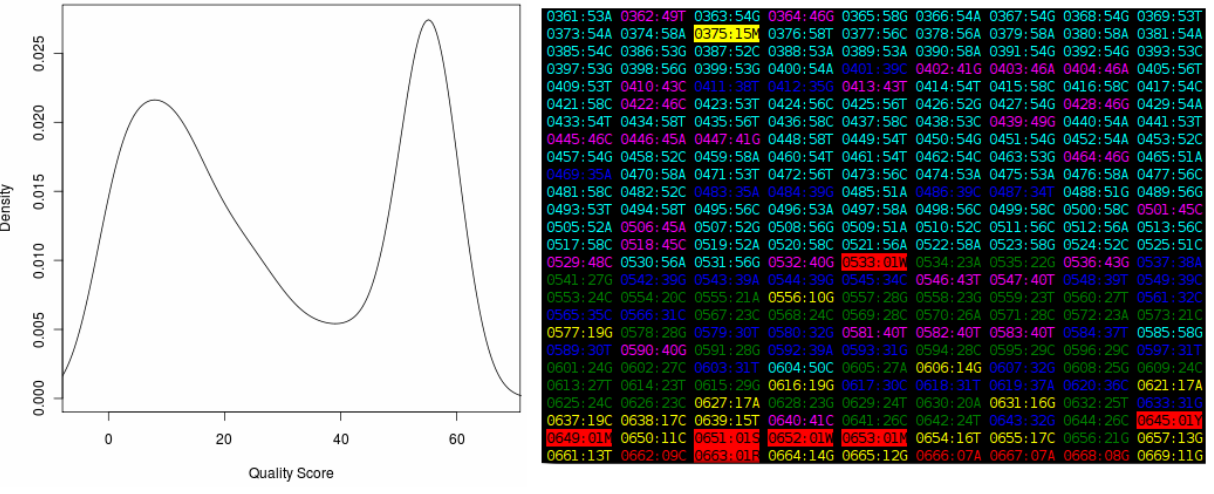
The output of the “Quality Score Analyzer” tool, showing the density plot on the left and a section of the “heat map” on the right. Each entry in this map is in the format “XXXX:YYZ”, where “XXXX” is the base position number in the sequence, increasing from “0001” for the first position in the file, and “YY” is the quality score from the chromatogram. The “Z” is the base called at the position. The color of each entry represents the quality score. Values in the range zero to nine (considered very poor) are shown in red, between 10 and 19 (poor) in yellow, between 20 and 29 (acceptable) in green, between 30 and 39 (good) in blue, between 40 and 49 (very good) in magenta and between 50 and 59 (excellent) in cyan. Quality scores higher or equal to 60, which are theoretical only, are shown in white. Ambiguous bases are shown in reverse colors (black text on a colored